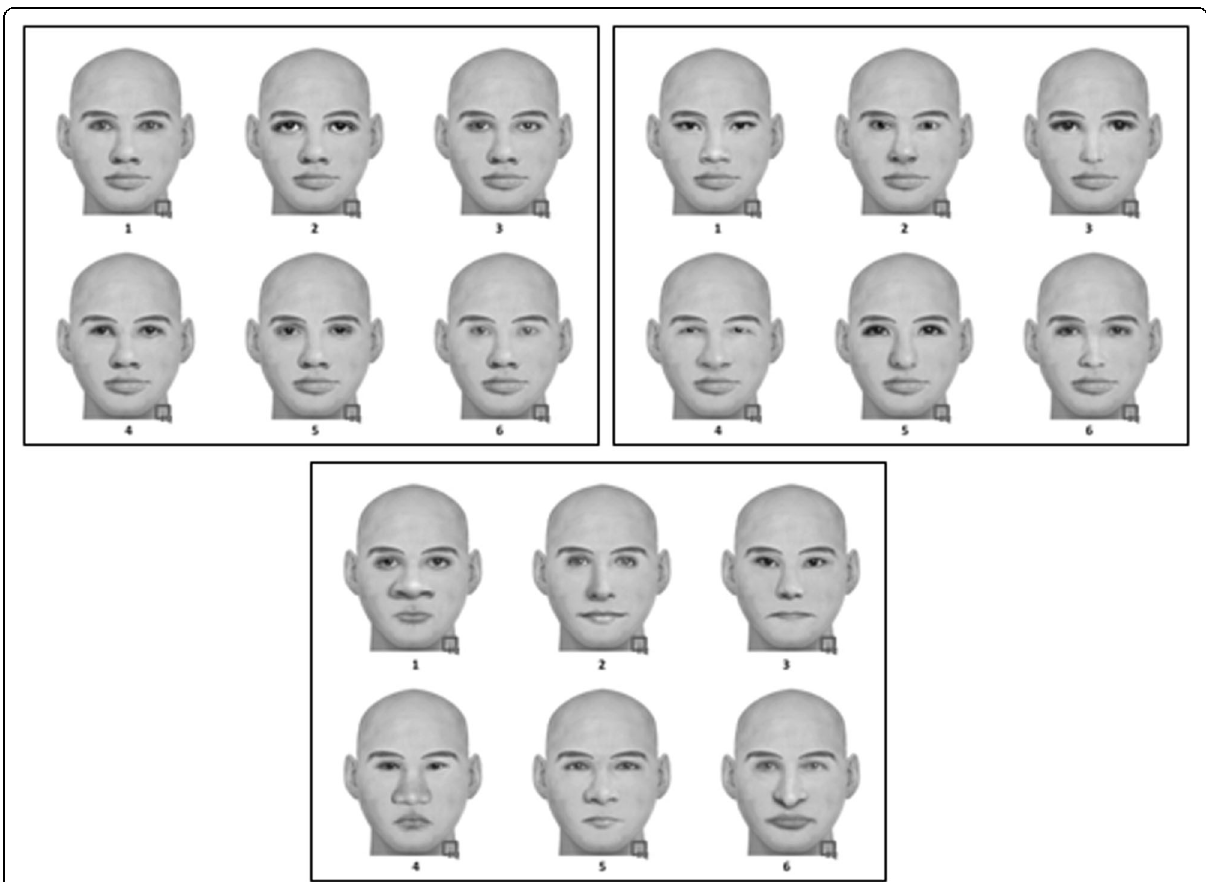
Fig. 1 Example lineups from Experiment 1 composed of facial stimuli from FACES 4.0. Only the eyes vary in the top left, the eyes and nose vary in the top right, and eyes, nose, and mouth vary in the